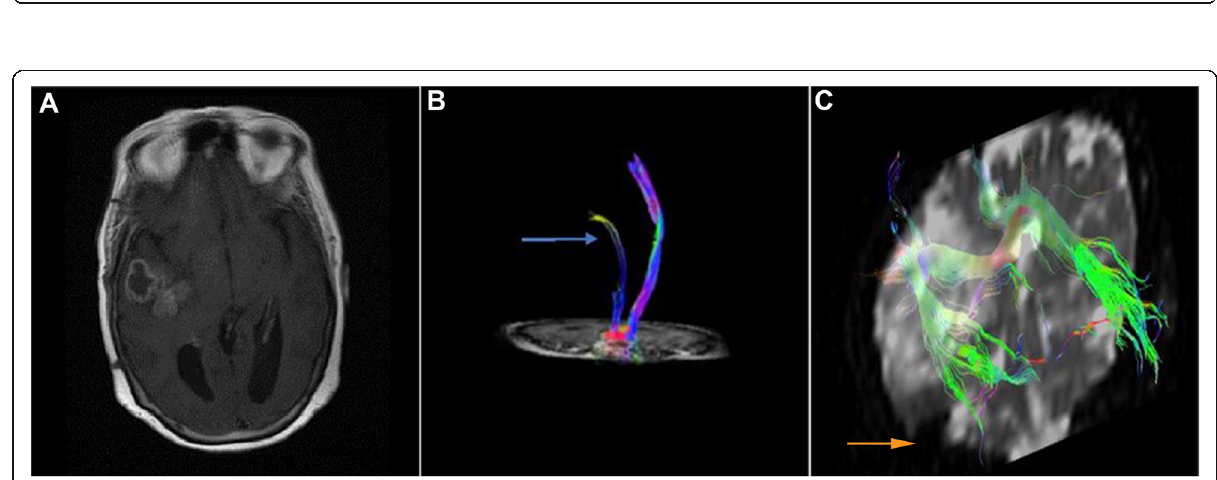
Fig. 4 Case number 2. Postoperative radiological examination of Fig. 3 patient. a Axial T1 WI with contrast revealing a small residual. b Coronal view with 3D reconstruction of the CST (blue arrow) shows no fiber position or fraction anisotropy improvement. c Coronal view with 3D reconstruction of the SLF tracts (orange arrow) revealing normalization of the position and